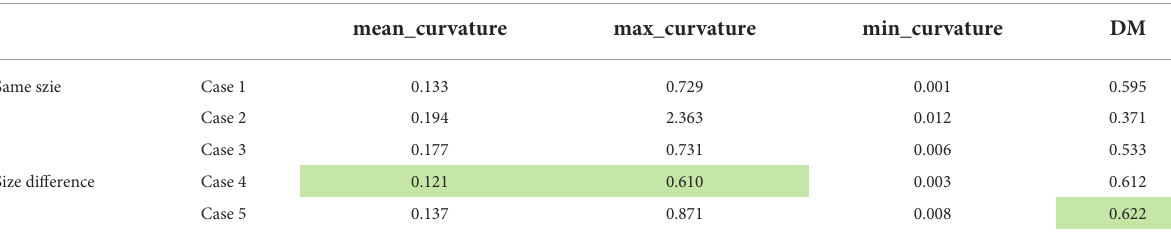
TABLE 2 The summary of the comparison of morphological parameters of different pre-aneurysm vasculatures. Morphological